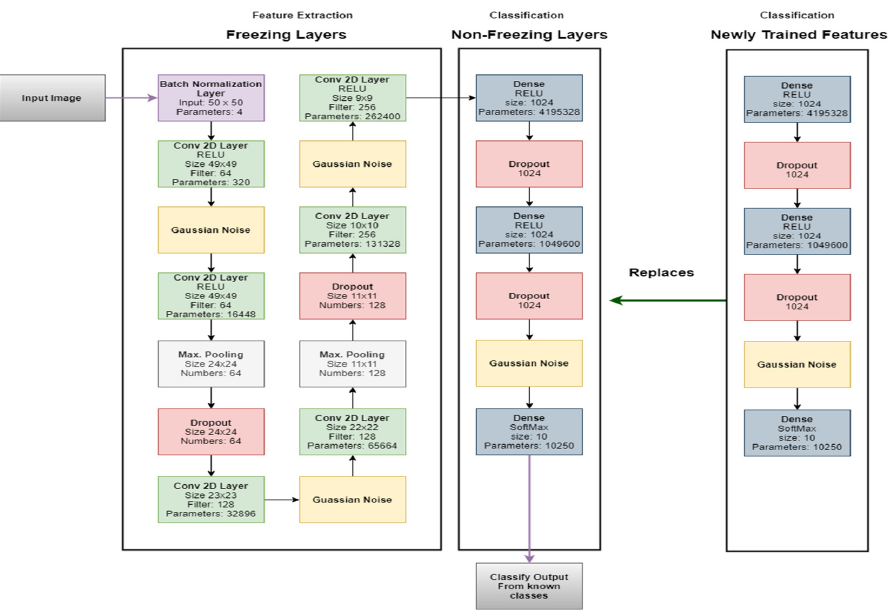
Figure 2. The process to update the existing classifier with new weights to handle class evolution.